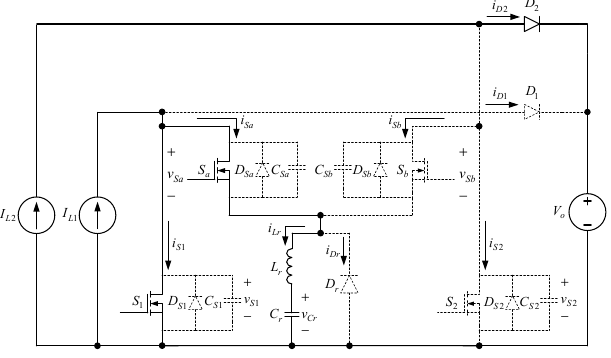
Figure 7. Current path in mode 4.